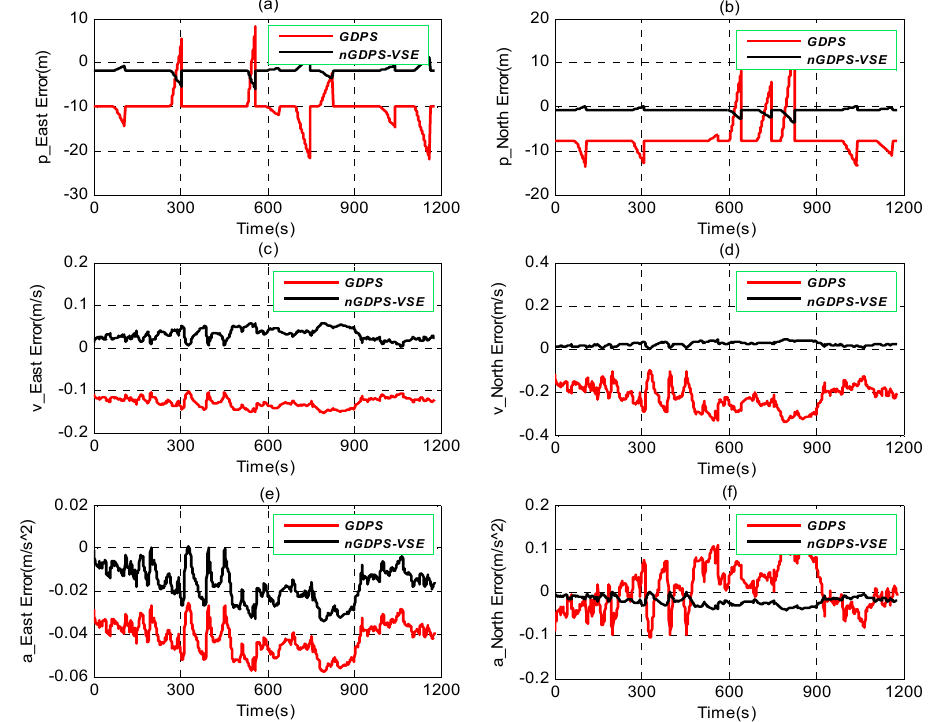
Figure 5. Vehicle state estimate (VSE) errors plot depicting the performance of GDPS, nGDPS-VSE through the influence of the non-Gaussianity related to the measurement noise. Position estimate: ( a ) East and ( b ) North. Velocity estimate: ( c ) East and ( d ) North. Acceleration estimate: ( e ) East and ( f ) North.